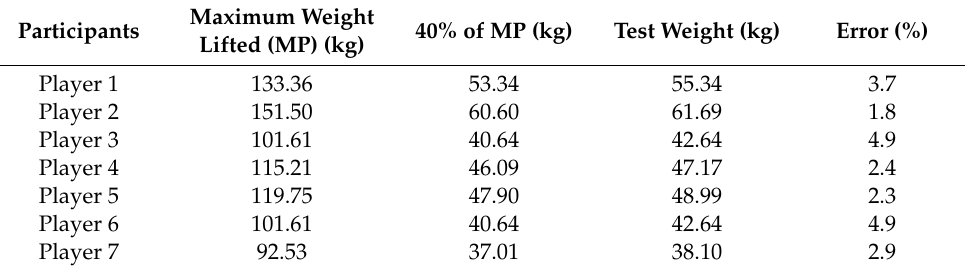
Table 5. Test weight defined for each